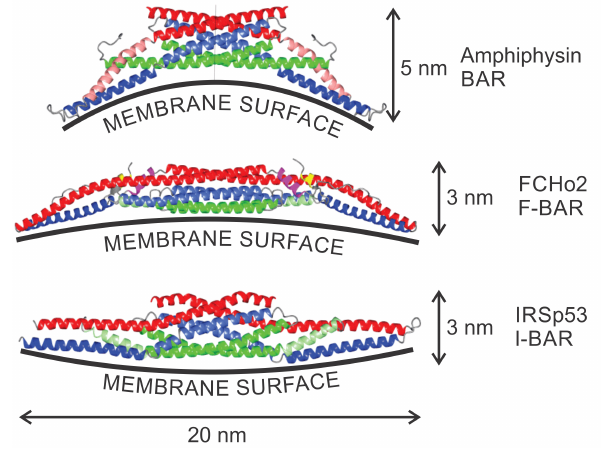
Figure 3. Schematic presentation of the Bin/Amphiphysin/Rvs (BAR) superfamily domains. BAR do- mains are shown along with their typical sizes and curvature preferences. Adapted with permission from refs. [18,108]. 2016